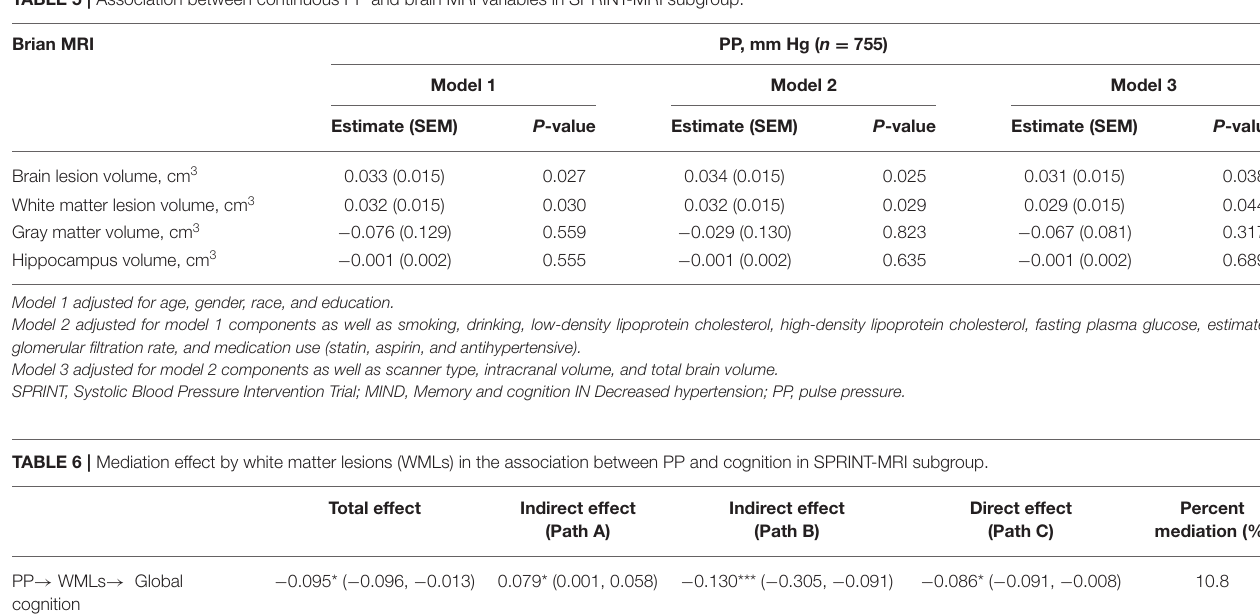
TABLE 5 | Association between continuous PP and brain MRI variables in SPRINT-MRI subgroup.